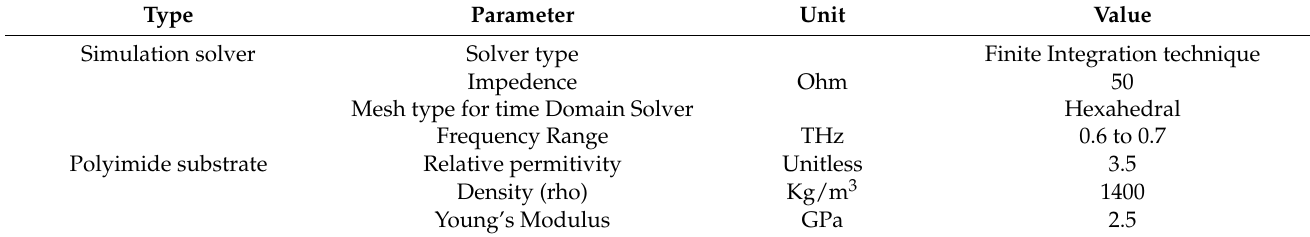
Table 2. Simulation parameters for the analysis of the proposed design.